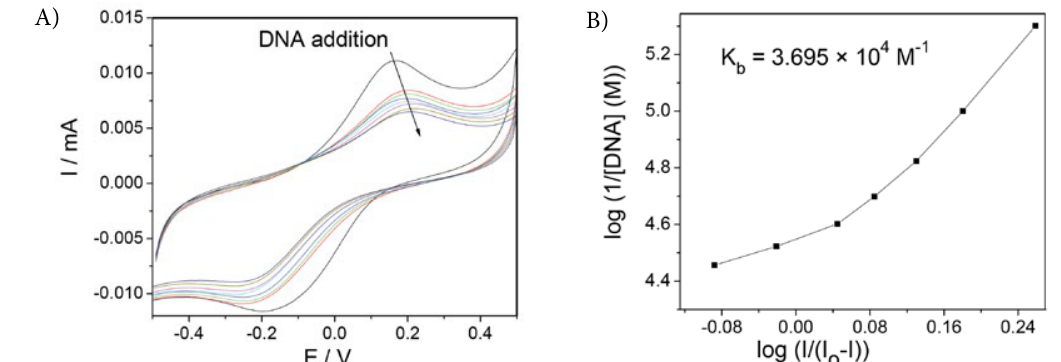
Fig. 4. A : voltamograms of complex at scan rate 100 mV/s in absence and presence of DNA showing a shift in peak potential towards more positive values. B : plot for calculation of binding constant K b